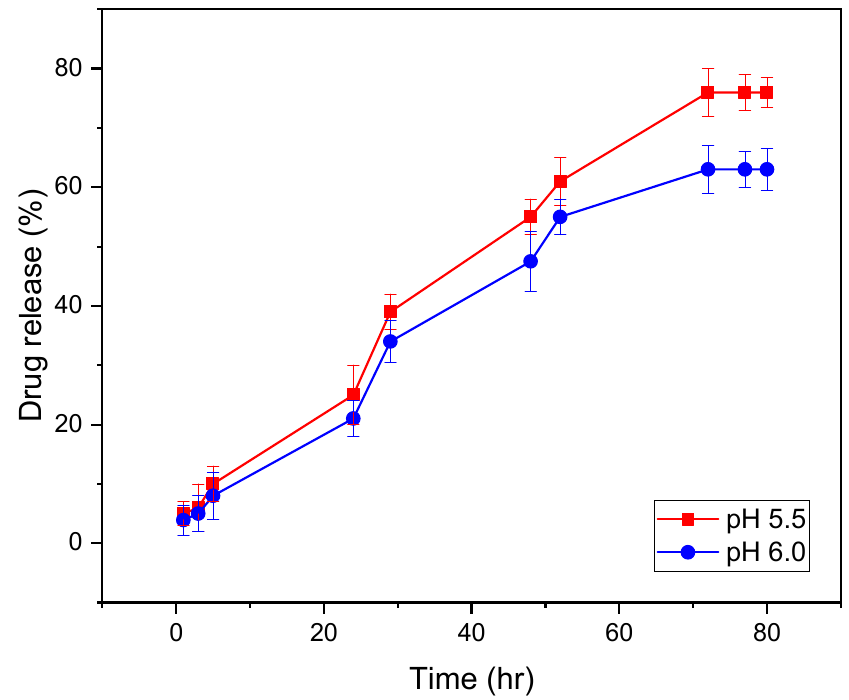
Figure 13. In vitro drug release profile of gentamicin sulphate from hydrogel in phosphate buffer solution at pH 5.5 and pH 6.0 .